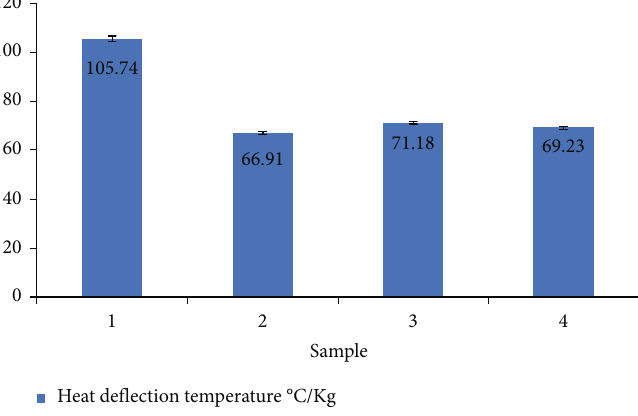
Figure 5: Heat de fl ection temperature of hybrid composites.